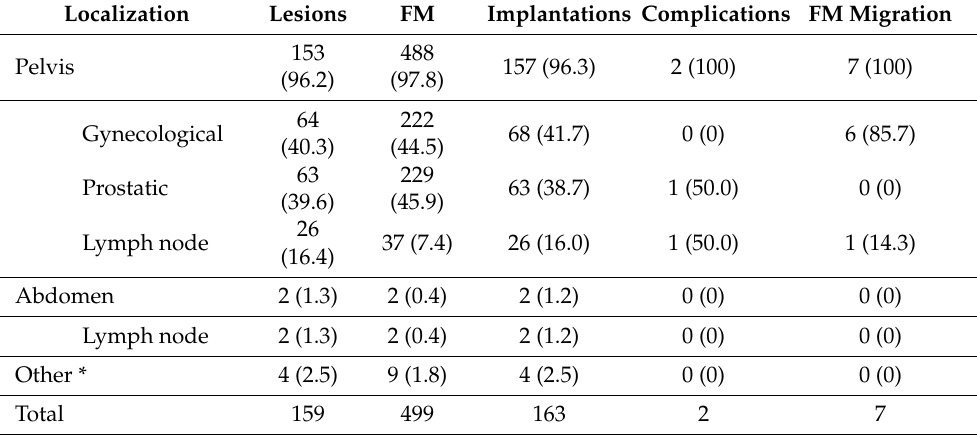
Table 4. Fiducial marker localization and complications in lesions that did not move with respiration using fiducial